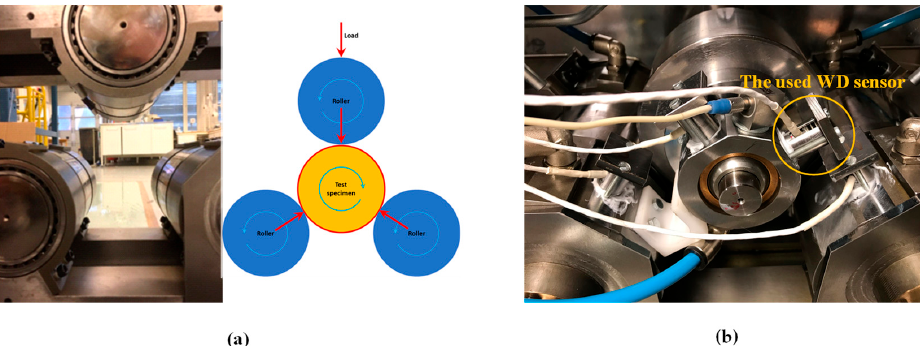
Figure 7. Display of the rolling fatigue test rig. ( a ) Photographic image and schematics of the geometry of supporting rollers and the testing roller, and ( b ) a close-up view of the setup instrumented with sensors.